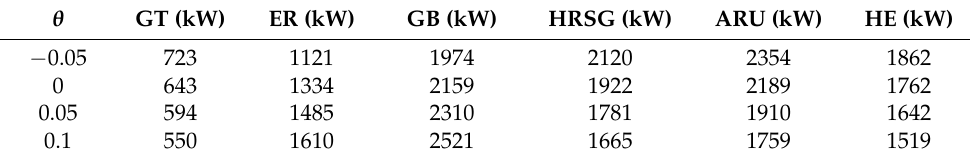
Table 5. The equipment capacity of the DES-HOS with a θ from − 0.05 to 0.1. GT (kW) ER (kW) GB (kW) HRSG (kW) ARU (kW) HE (kW)